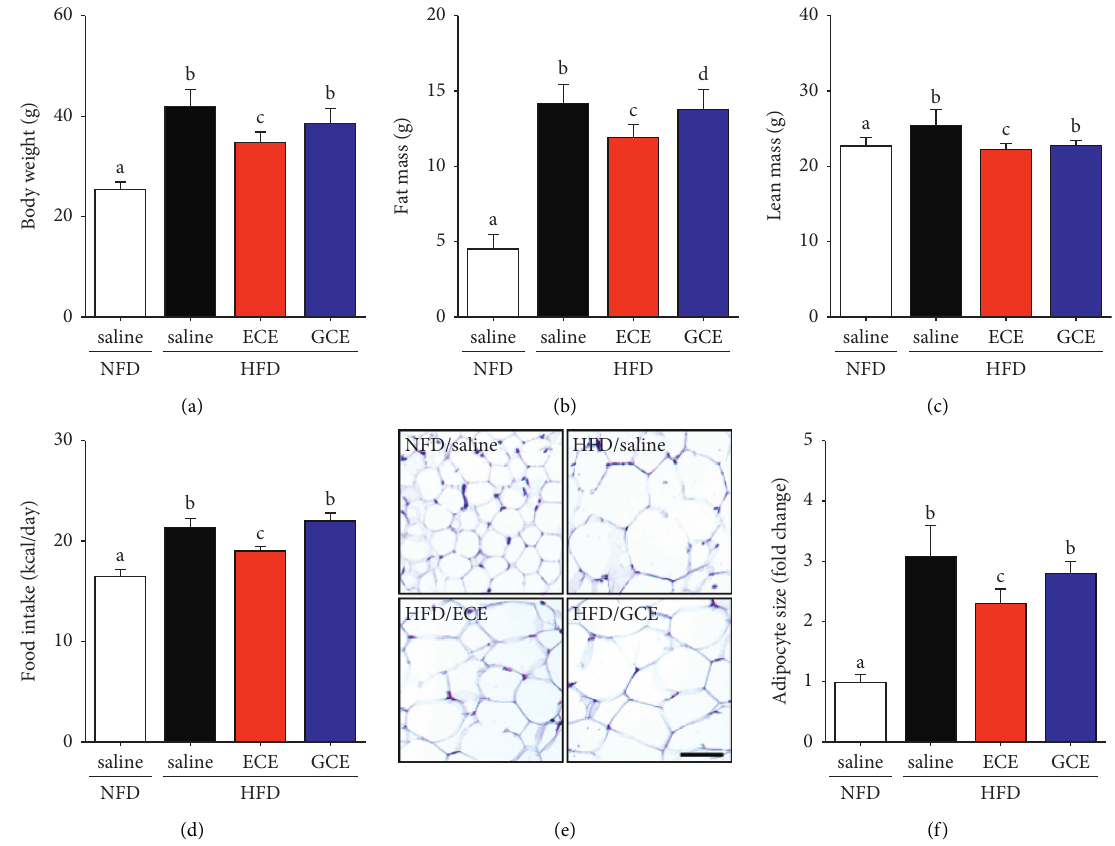
Figure 1: Effects of E . cava extract on body weight, adiposity, food intake, and adipocyte sizes in high-fat diet- (HFD-) induced obese mice. Mice fed with standard normal fat diet (NFD; open bar) or HFD (HFD; black bar) for 4 weeks and then 0.9% saline (NFD/saline group and HFD/saline group), 70 mg/kg/day E . cava extract (HFD/ECE group; red bar) or 500mg/kg/day Garcinia cambogia extract (HFD/GCE group; blue bar) orally administrated for the next 4 weeks. After 8 weeks of administration, (a) body weight, (b) fat mass, (c) lean mass, and (d) food intake were measured. (e) Hematoxylin and eosin (H&E) stained images showing adipocytes in visceral fat and (f) a graph showing average visceral adipocyte size in representative H&E stained images. Adipocyte size was expressed as folds of that of NFD/saline group. Scale bar � 200 μ m. The same letters represent no significant difference ( p < 0 .